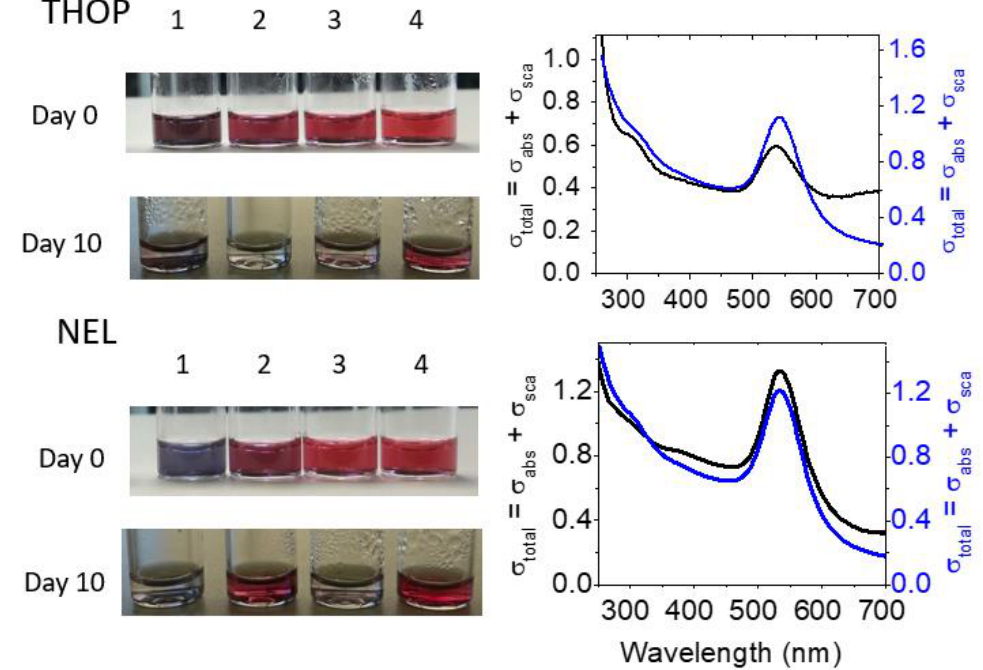
Figure 8. Colloidal stability of THOP-GNP and NEL-GNP. The stability of GNPs produced by HEPES assisted by proteases at the four tested concentrations was followed for 10 days. The left panel depicts the visual aspects of fresh synthesized (day 0) and protein-GNP after 10 days. The UV-vis spectra of rTHOP (2 nmol. L −1 ) and rNEL (2 nmol.L −1 ) nanoparticles after 10 days (black lines) indicate the colloidal stability of both rTHOP-GNP and rNEL-GNP preparations compared to freshly synthesized protein-GNPs (day 0, blue line). The lower stability of rTHOP-GNP produced with 200, 40 and 8 n nmol.L −1 , and rNEL-GNP produced with rNEL at 200 nmol.L −1 and 8 nmol.L −1 leading to nanoparticle precipitation is noteworthy.